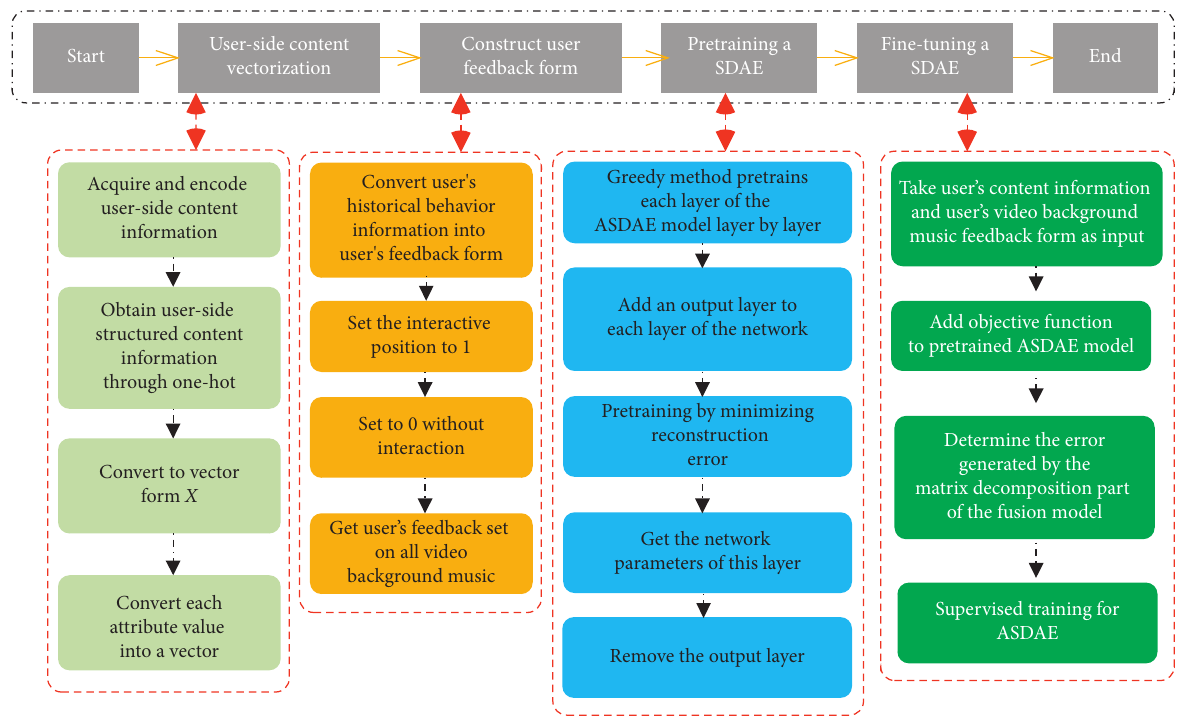
Figure 2: Flowchart of user interest mining based on extended